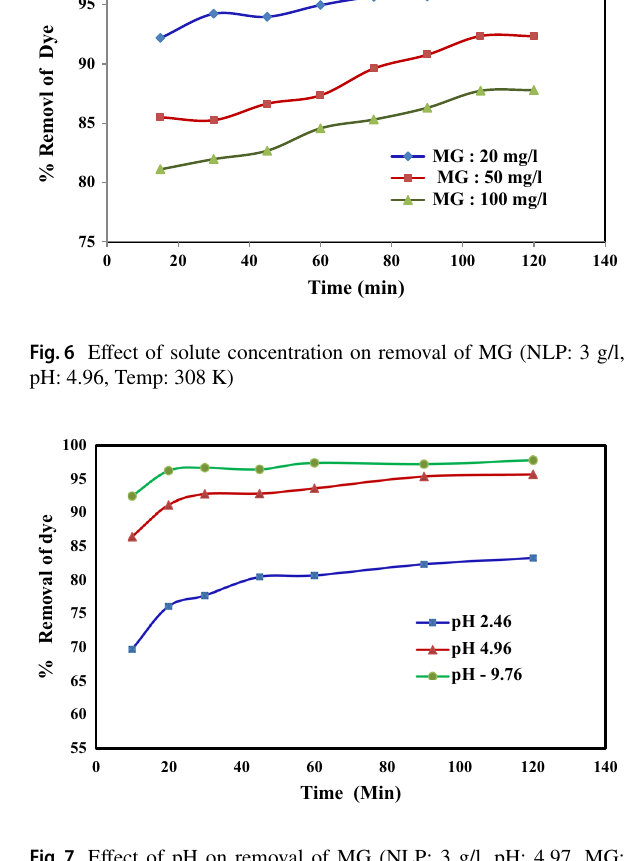
Fig. 9 Effect of temperature on adsorption of MG (NLP: 3 g/l, pH: 4.97, MG: 100 mg/l, Temp: 308